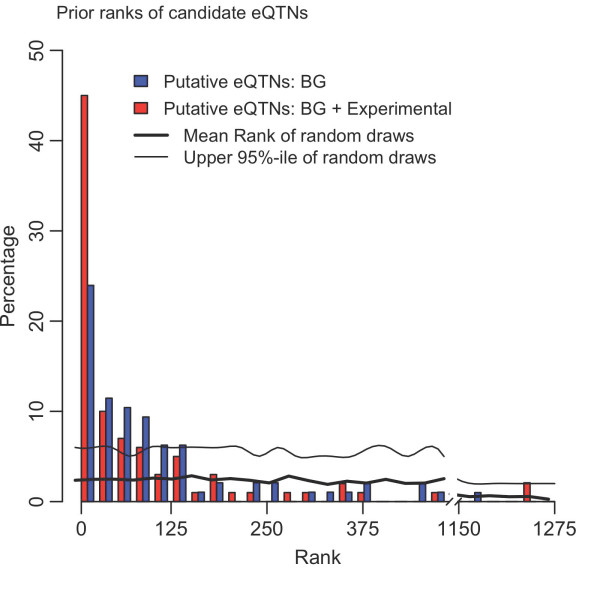
Prior rankings of SNPs for 100 genes where a single SNP is a clear best candidate for being the 'true' eQTN using the prior probability from the hierarchical model. The histogram shows the percentage of genes for which the putative causal site is ranked by the prior among the top 1 to 15 SNPs, 15 to 30 SNPs, and so on. Typically, the candidate region for each gene contains approximately 1,200 SNPs. The two prior models correspond to the distance model only (blue) and the distance model plus experimental annotations (red). The 100 genes analyzed here were excluded from all other analyses. BG, background.